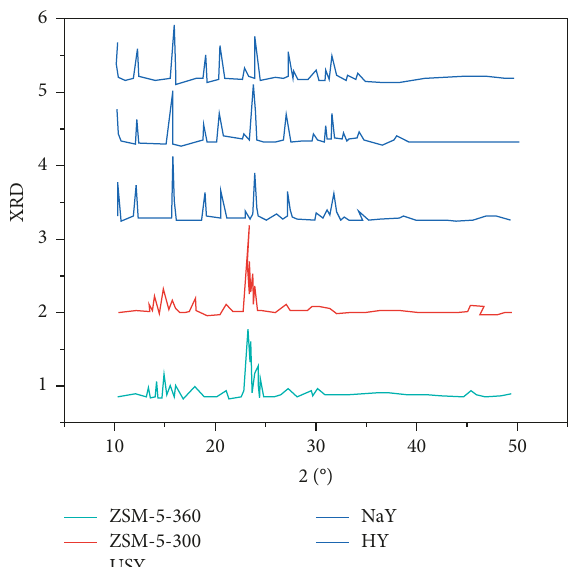
Figure 3: Adsorption breakthrough curve of molecular sieve for toluene. Note: Airspeed 5000h − 1 . The adsorption conditions are normal pressure, (35 ± 2) ° C, molecular sieve loading 2.0g, toluene and ethyl acetate concentration 500mg/m 3 , and water vapor RH �